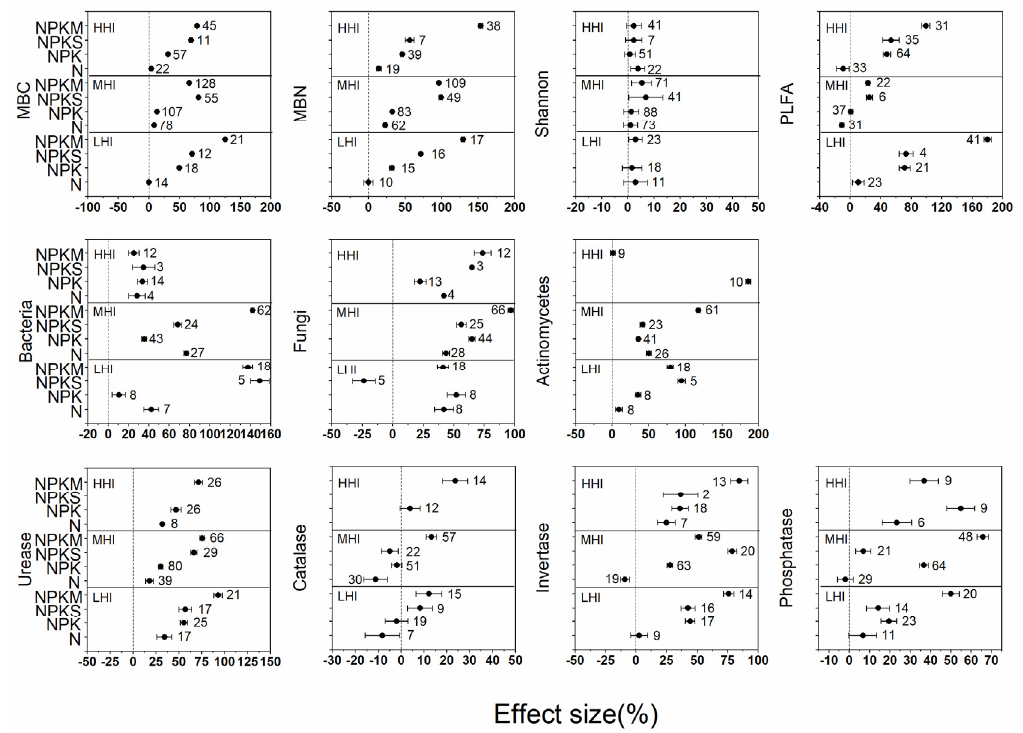
Figure 4. The effect sizes of fertilization on soil microbial properties (MBC, MBN, the Shannon in- dex, PLFA, bacteria, fungi, Actinomycetes , urease, catalase, invertase, and phosphatase) by meta − analysis according to humidity index of four main fertilizer regimes (N, NPK, NPKS, and NKPM). The numbers approximating the black dots are the data numbers. N: sole nitrogen fertilizer; NPK: the phosphorus, potassium, and nitrogen fertilizer; NPKS: NPK combined with straw; NPKM: NPK combined with manure; LHI: arid regions (HI ≤ 25); MHI: semi − arid regions (25 < HI < 50); HHI: humid regions (HI ≥ 50).